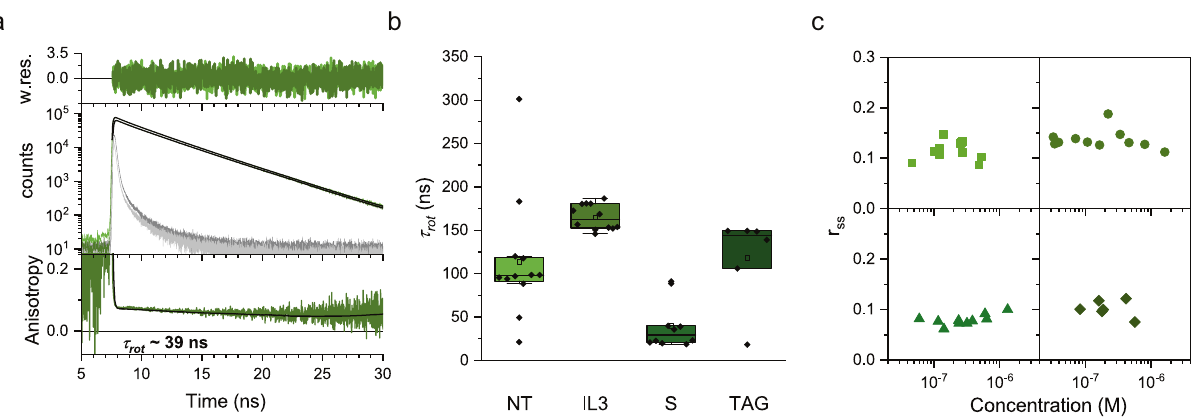
Fig. 3 Time-resolved anisotropy show fast rotational correlation dependent on fl uorophore position. a Photon arrival time histograms of vertically (green) and horizontally (light green) polarized photons arising from a CHO-K1 cell transiently transfected with N-terminal-SNAP- β 2 -AR conjugated to Alexa Fluor 488 dye. The instrument response functions (IRF) for vertical and horizontal polarization are shown in gray and dark gray, respectively. The histograms were fi t globally with Eqs. (7) and (8) to obtain a slow rotational correlation time ( τ rot ) of 39 ns. The fi ts are shown in black. The bottom panel gives the reconstructed anisotropy decay and the corresponding fi t. Weighted residuals corresponding to the global fi ts are shown on top. b Rotational correlation times of all β 2 -AR constructs, naming and color scheme as in Fig. 2. NT shows 113.7 ± 70.5 ns; IL3 shows 165.1 ± 14.6 ns; S shows 40.0 ± 27.5 ns and TAG shows 118.3 ± 51.8 ns. Please note that from biexponential rotational correlation time fi tting, the slower τ rot was used. Data are mean ± s.d. c Steady-state anisotropy ( r ss ) is largely independent from receptor density within the measured concentration range of all β 2 -AR constructs. Squares represent NT, circles represent IL3, triangles represent S and diamonds represent